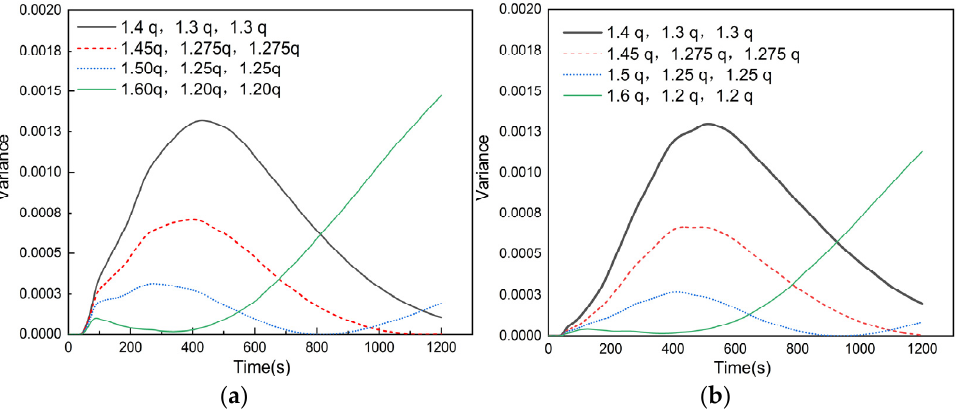
Figure 24. Variance of outflow percentage of the double-weir tundish with non-uniform increasing casting flow rate under single-strand blockage conditions: ( a ) strand 1 blockage, ( b ) strand 2 blockage. For the strand 2 blockage condition, the outflow percentages (at 1200 s) of strand 1, strand 3 and strand 4 are (29.86%, 32.19%, 32.39%), (31.23%, 31.63%, 31.64%), (32.59%, 31.01%, 30.96%), and (35.43%, 29.67%, 29.55%) for the cases where the flow rates of strand 1 are 1.4 q, 1.45 q, 1.5 q and 1.6 q, respectively. The result is similar to the previous one.